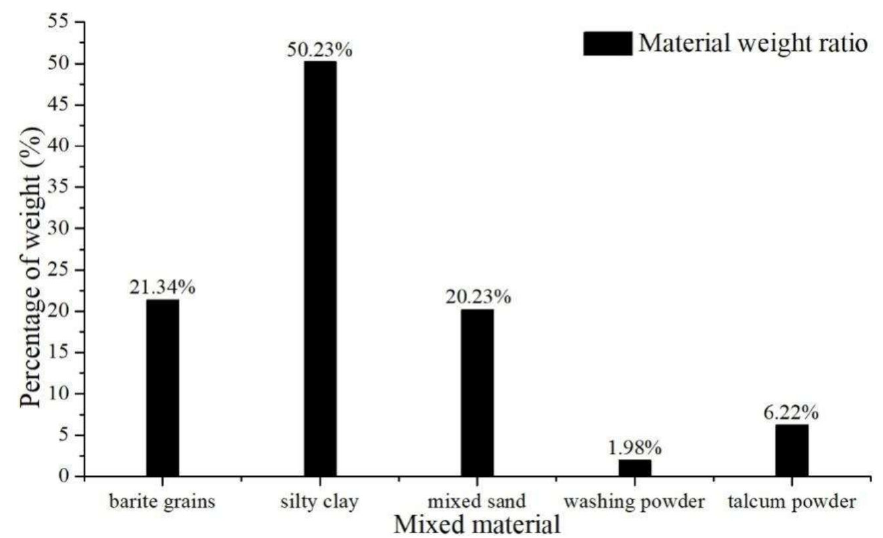
Figure 5. Composition and ratio of soil mixture.